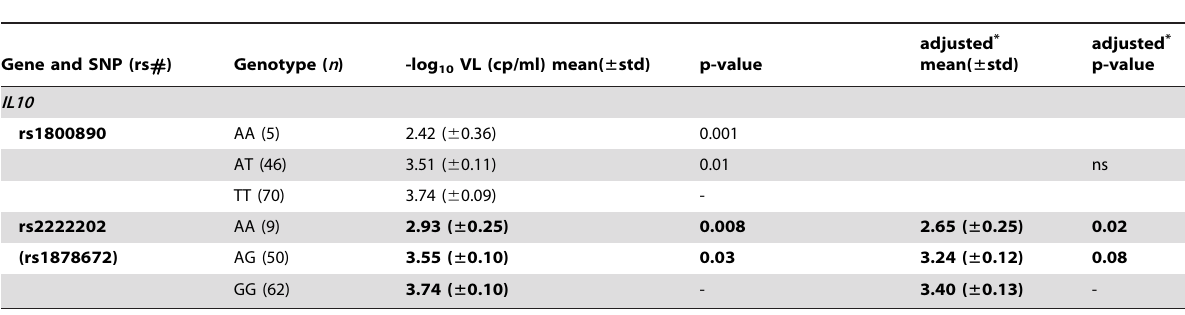
Table 2. Difference in viral-load set-point by genotype in IL10 gene